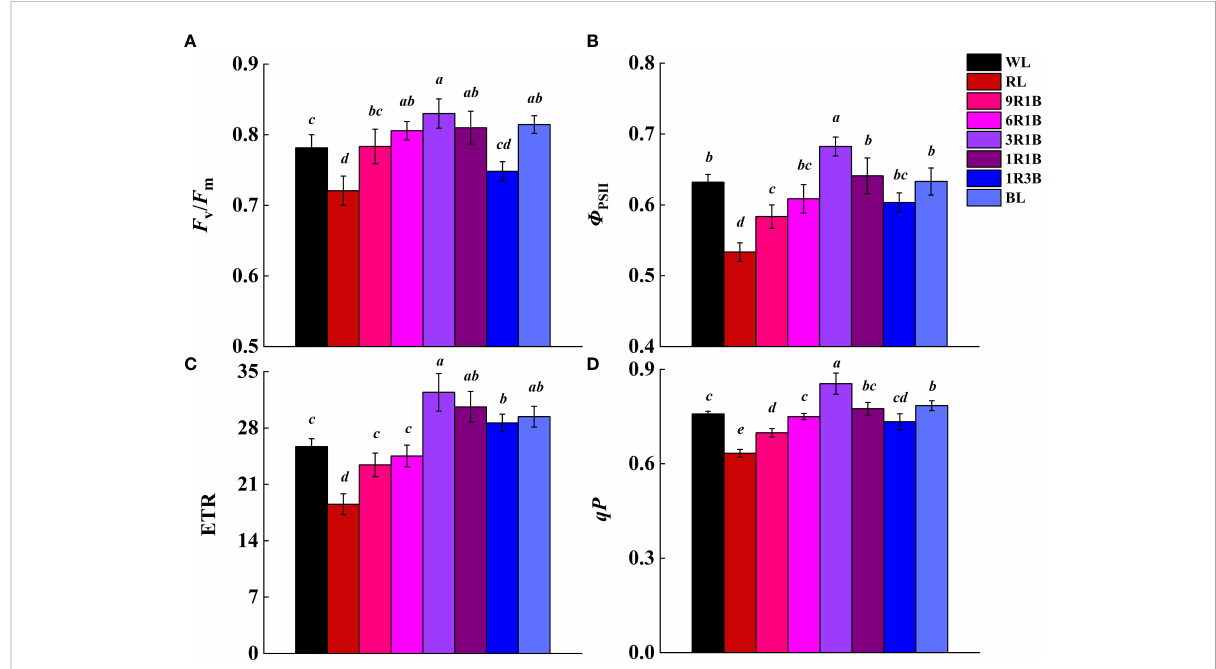
FIGURE 7 Effect of monochromatic and mixed red and blue light on chlorophyll a fl uorescence parameters of leaves from sweet pepper seedlings at day 30 after treatment. (A) F v / F m ; (B) F PSII ; (C) ETR; (D) qP . Difference in lower-case letters indicates signi fi cant difference at P <